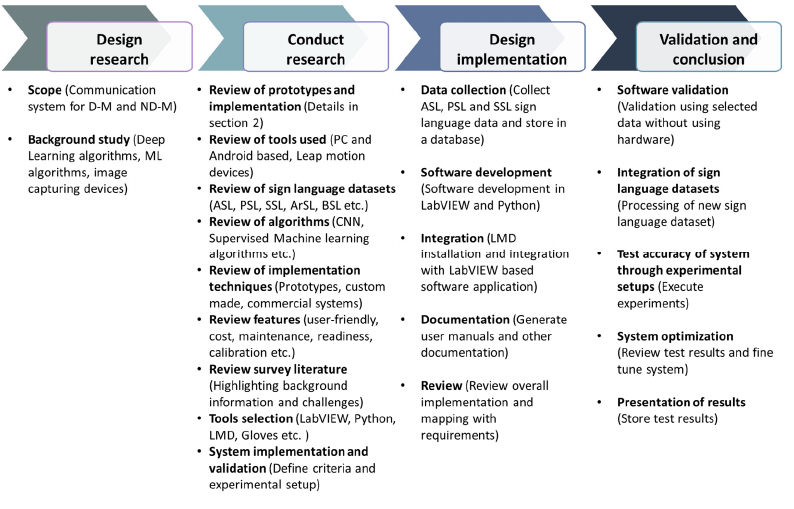
Figure 2. Research